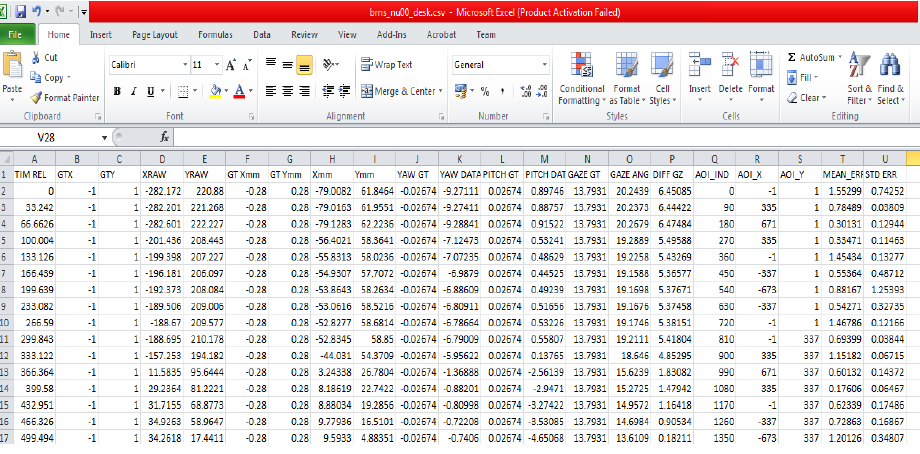
Figure 17. Python code snippet to read data from a gaze data file from NUIG_EyeGaze01 repository.